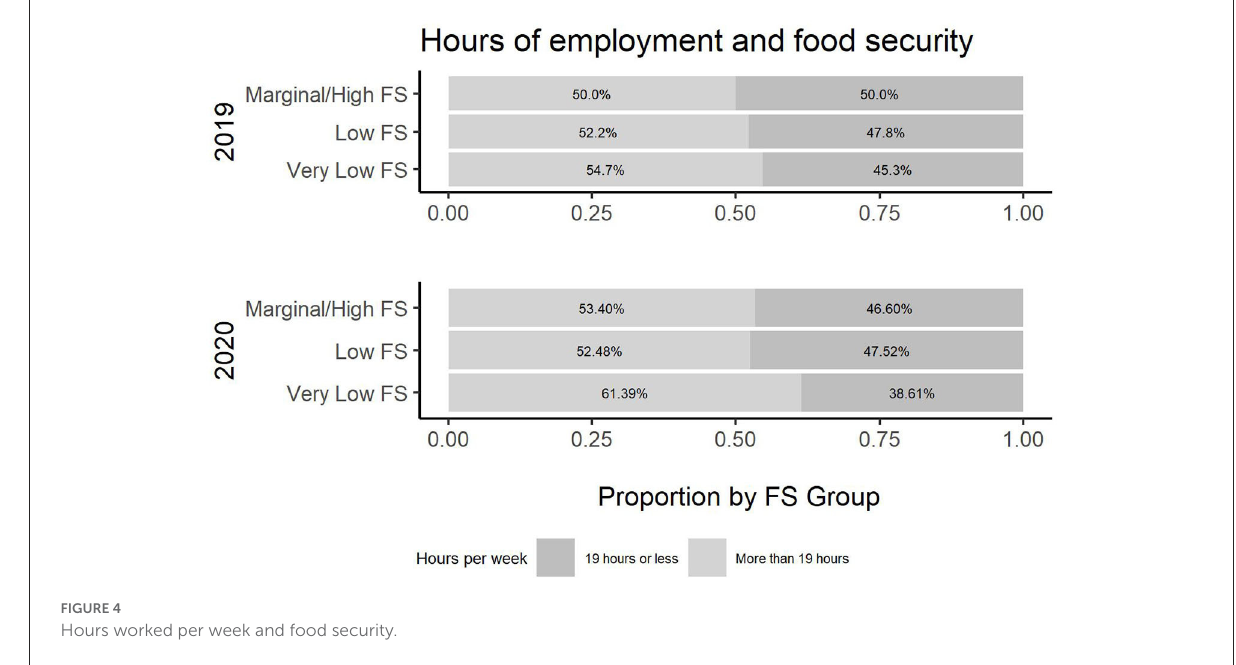
FIGURE4 Hours worked per week and food security.